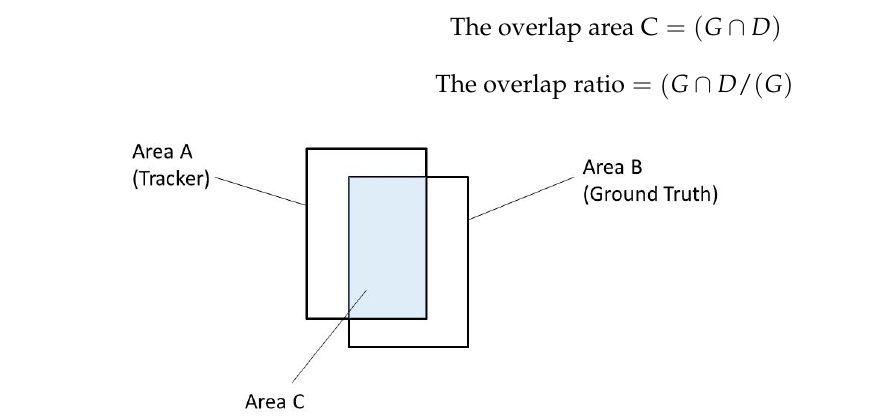
Figure 7. The overlap is used to evaluate the tracking ability.